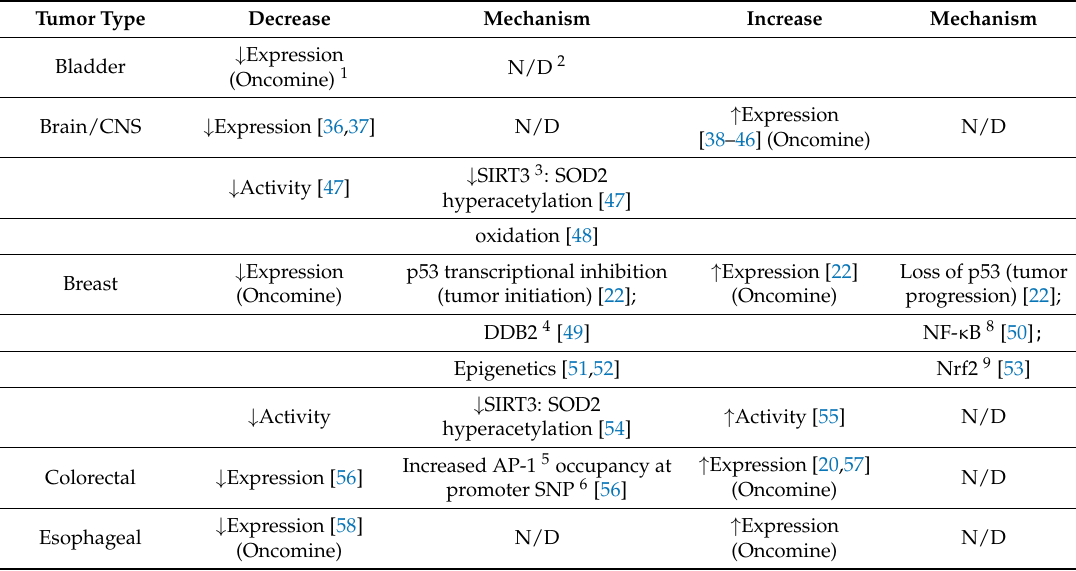
Table 1. Examples of regulatory mechanisms leading to dichotomous SOD2 expression and activity in